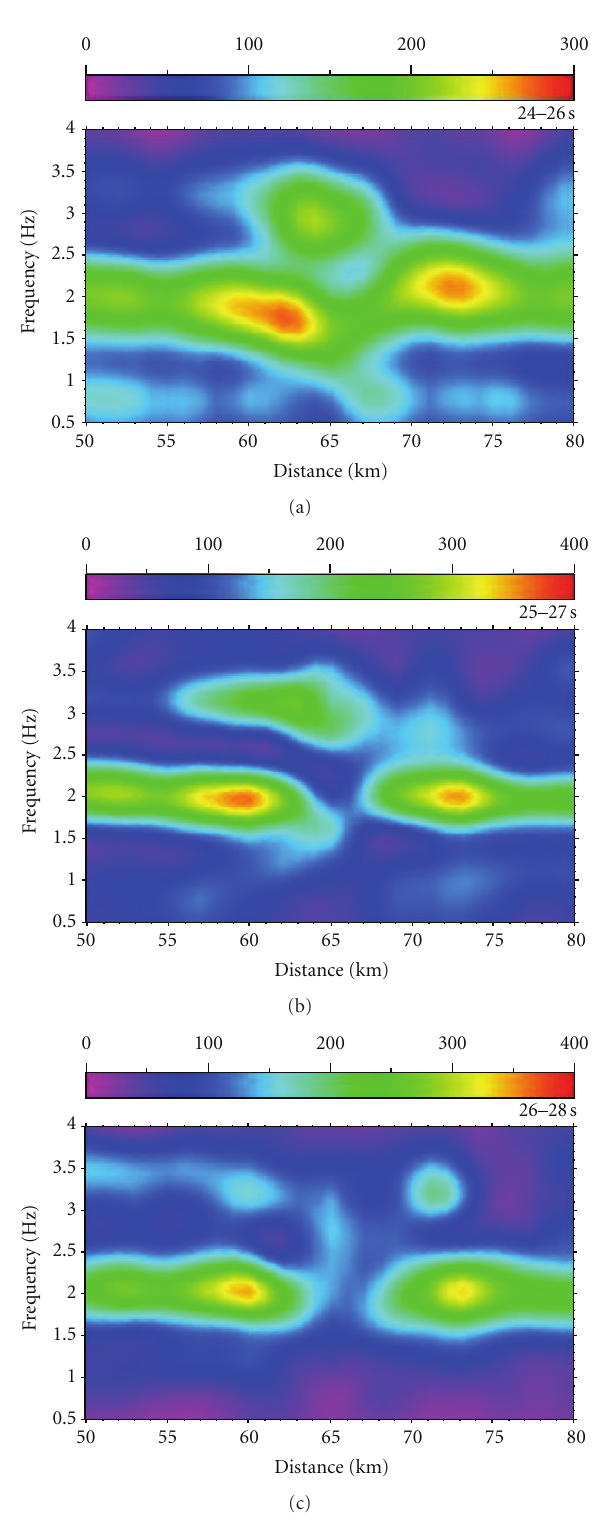
Figure 8: Contour maps showing amplitudes of seismic energies plotted in the frequency-distance domain for traces of the Kermadec Is. Earthquake (event#; eq012; after [23]). Spectra are taken from the traces aligned on the direct P. Time windows are shown at the upper right of each plot (from upper to lower; 24–26 s, 25–27 s, and 26–28 s,